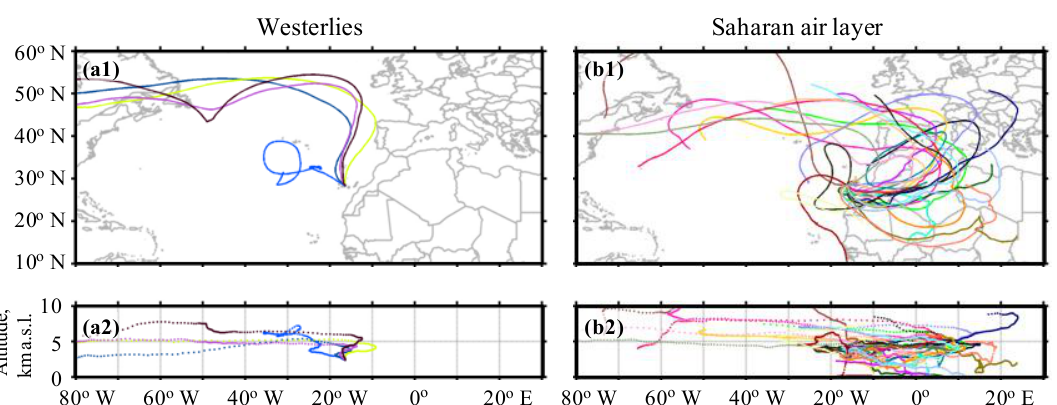
Figure 1. Ten-day back-trajectories based on HYSPLIT model for the samples collected within the (a) westerlies (26–30 August) and (b) the Saharan Air Layer (1–25 August and 31 August–1 September); the dates refer to the day of completion of the sampling.